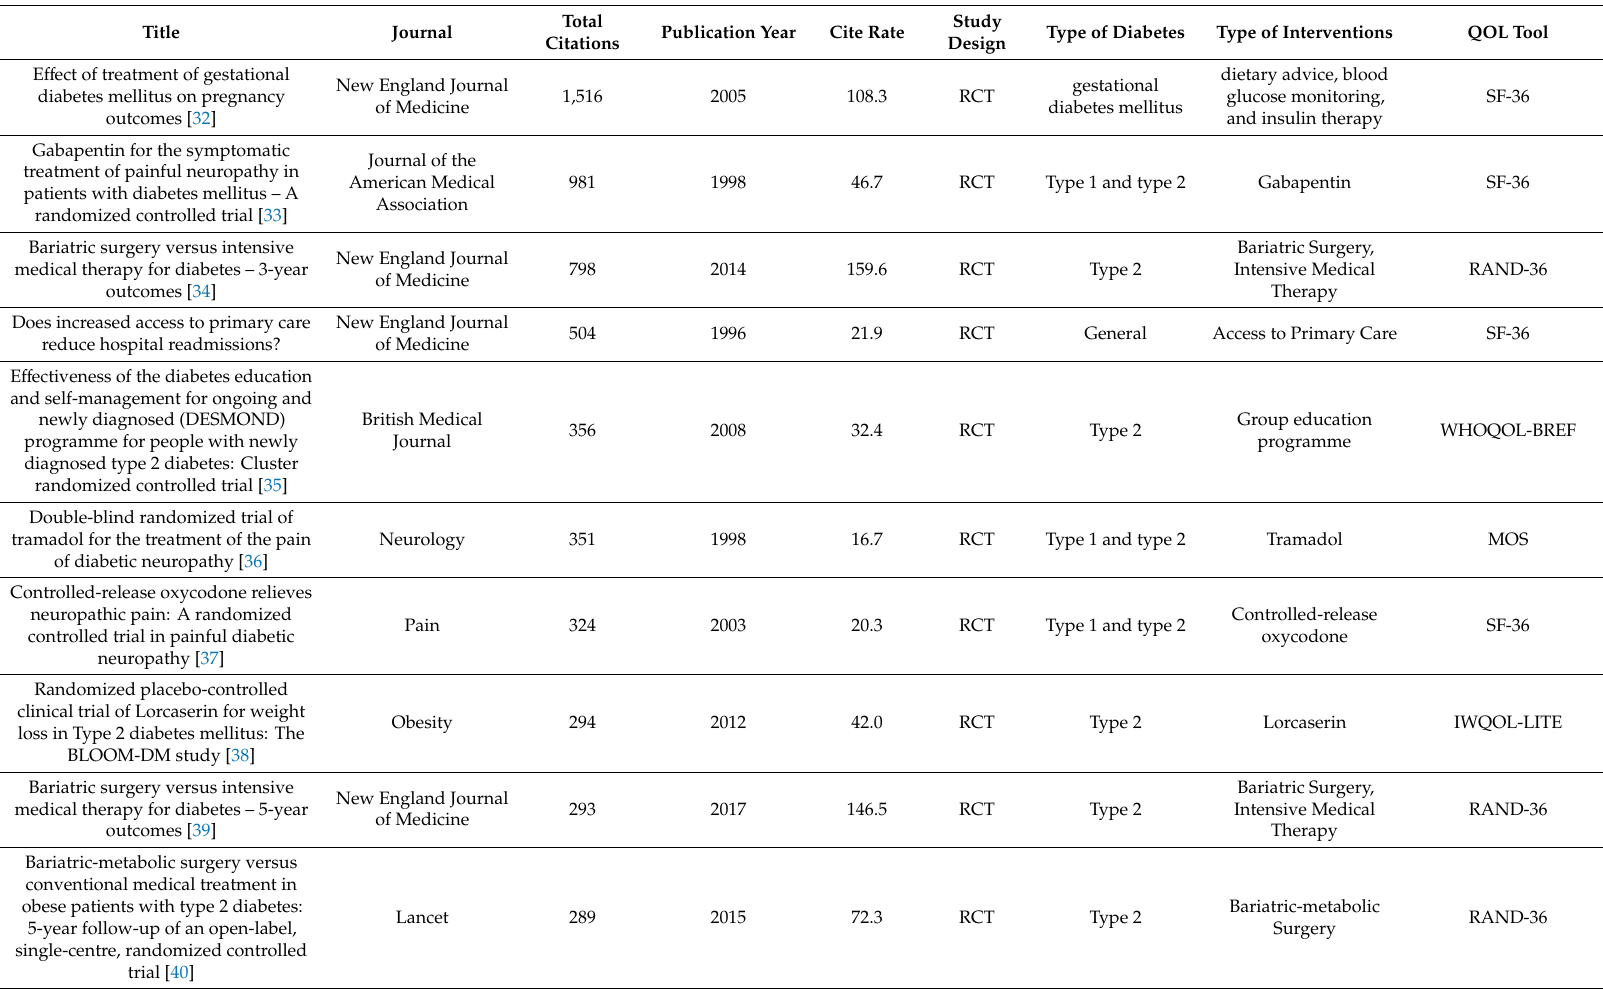
Table 2. Top 10 most cited clinical